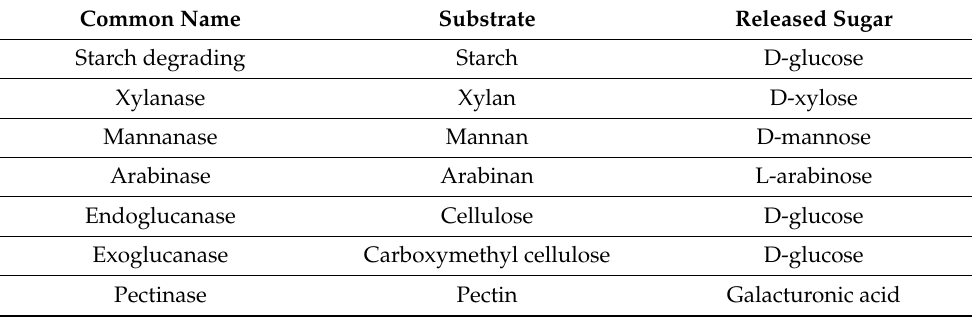
Table 2. Quantification of different enzymes using